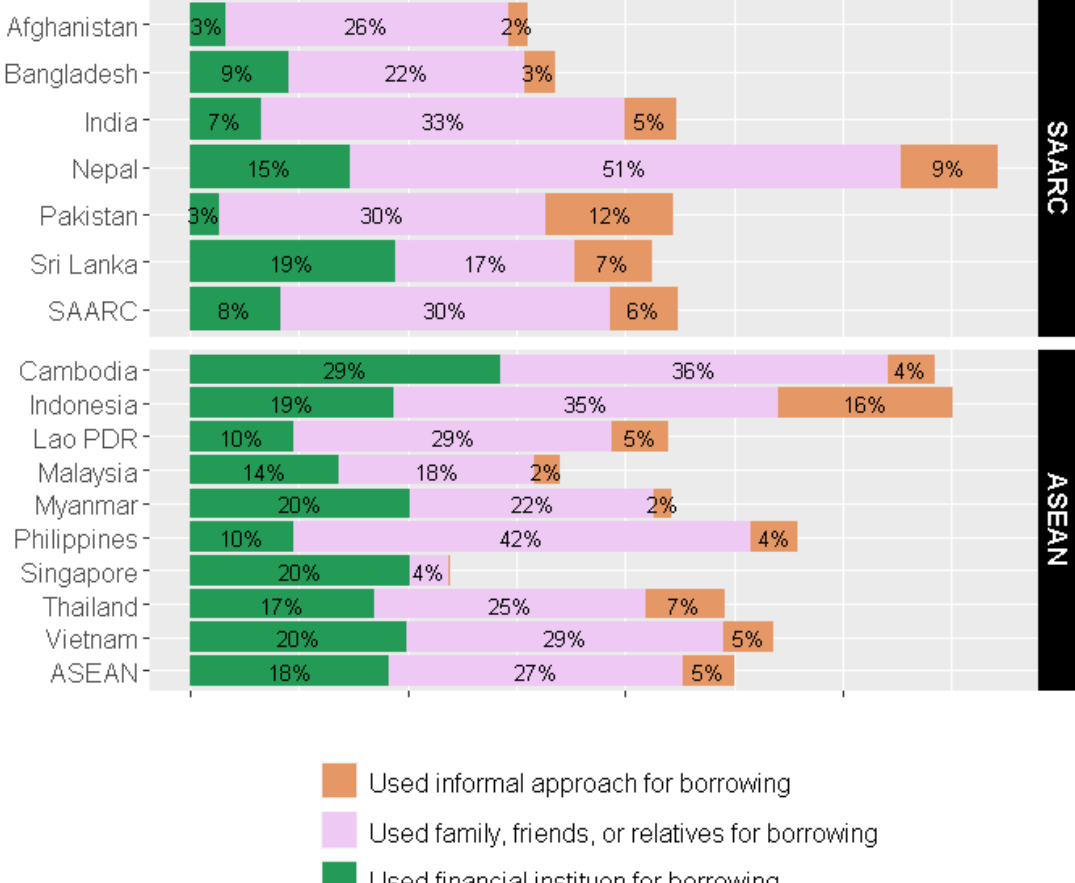
Figure 8. Percentage of participants who borrowed money from a bank or a financial institution, and who borrowed from informal sources, friends or family, or relatives.